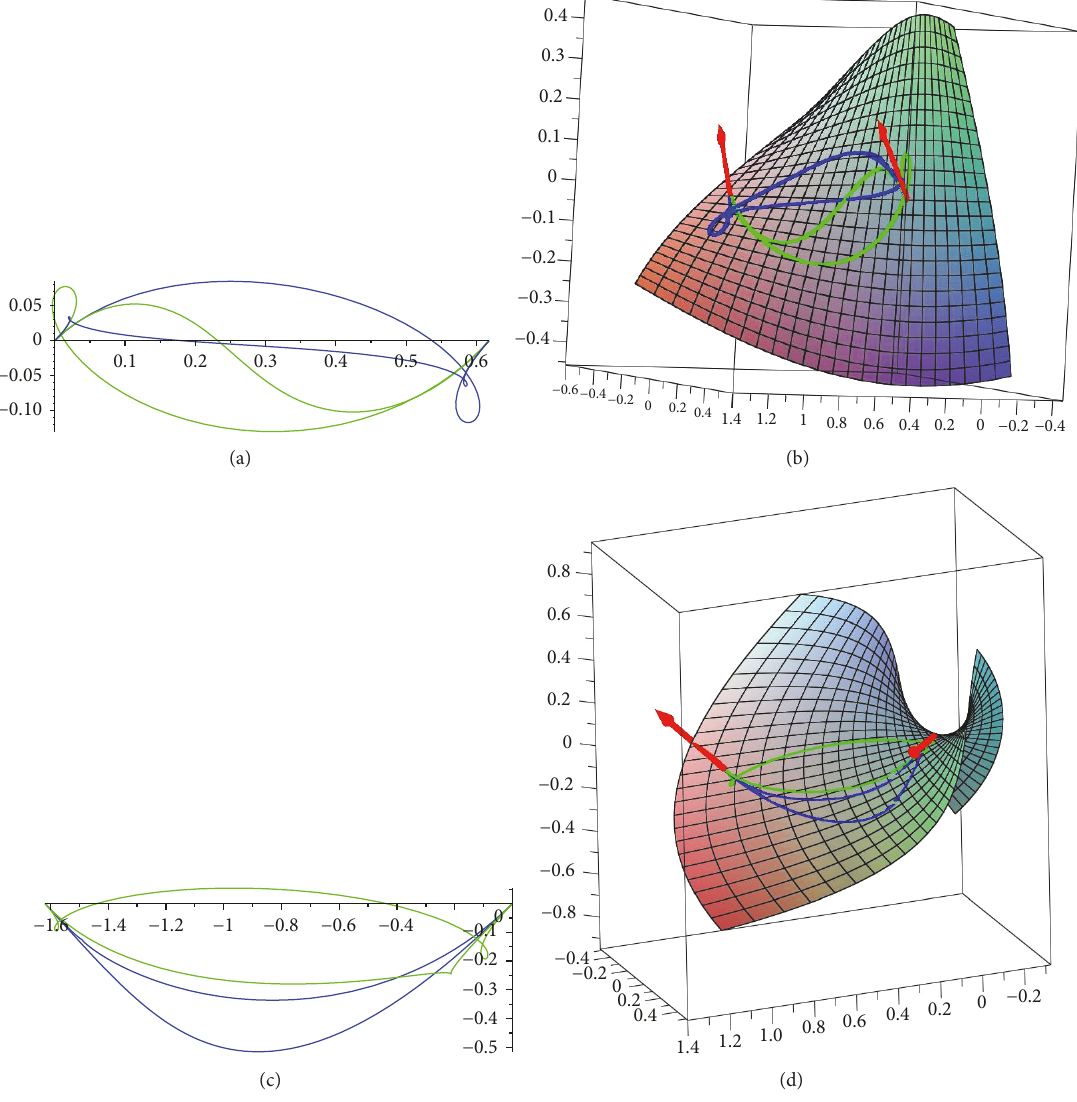
̃𝐻 1 𝑗 = 1, 2 ) in Example 13: (a) four interpolants satisfying ̃𝐻 1 𝐶 𝑗 ( ̃ 𝐻 1 𝐶 2 ; (d) four interpolants satisfying